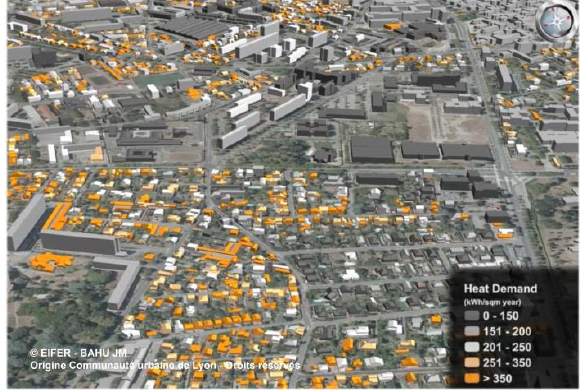
Figure 3: Representation of the heat demand results of residential buildings considering the scenario A “construction state”. Figure 4 and Figure 5 describe the distribution of heat energy demand for all the residential buildings resulting from the scenario A. Figure 6 describes the same for scenario B.